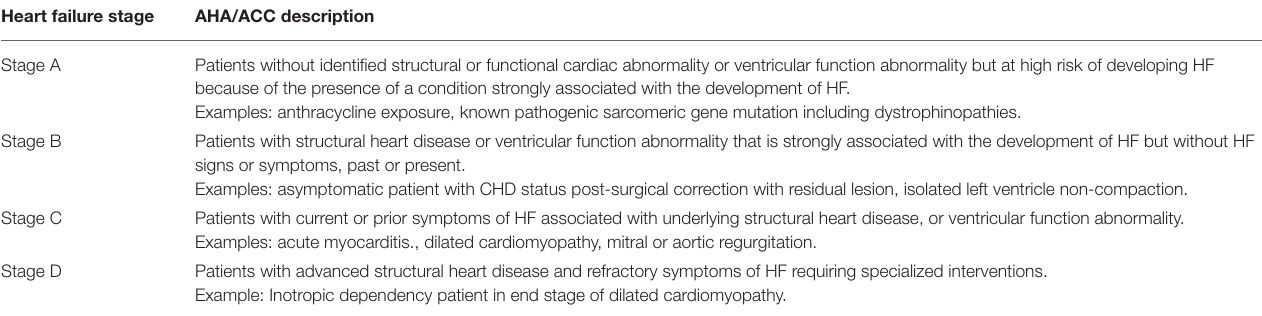
TABLE 3 | Classification of HF accordingly with the American heart association and American college of cardiology